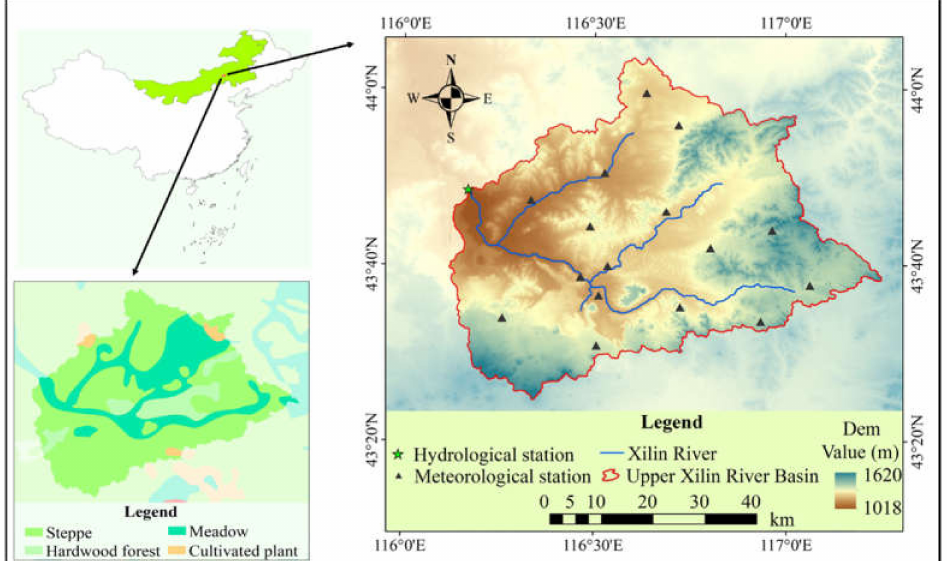
Figure 1. Location of the Xilin River Basin and spatial distribution of hydrometeorological stations, and the vegetation types. (Dem is the abbreviation for digital elevation